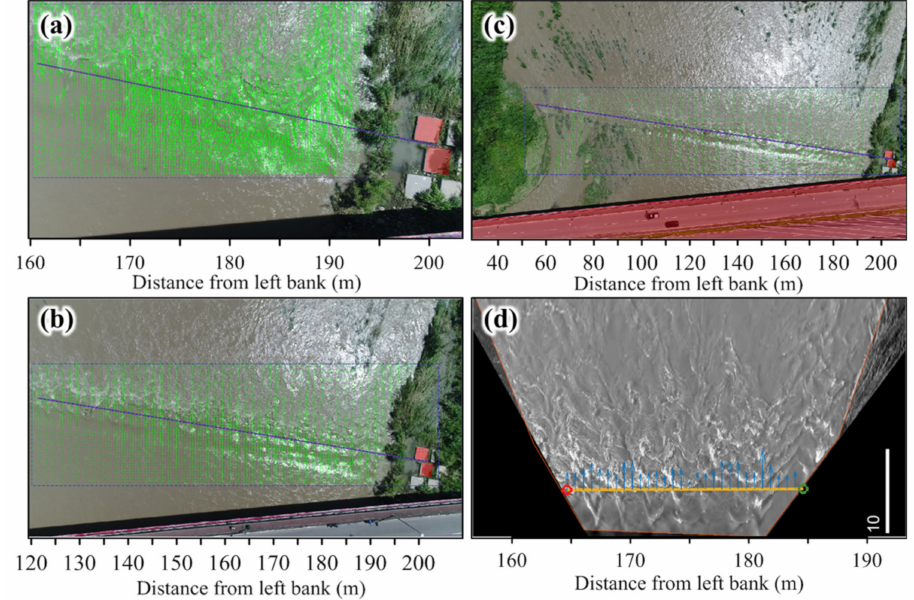
Figure 9. Flow field measurements obtained using LSPIV derived from UAVs with different flight heights: ( a ) 32 m, ( b ) 62 m, and ( c ) 112 m. ( d ) The flow field using LSPIV from a terrestrial fixed station at 12 heights. The blue line in the figure represents the x -axis